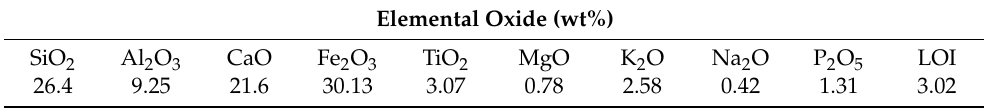
Table 1. Chemical composition of Class C fly